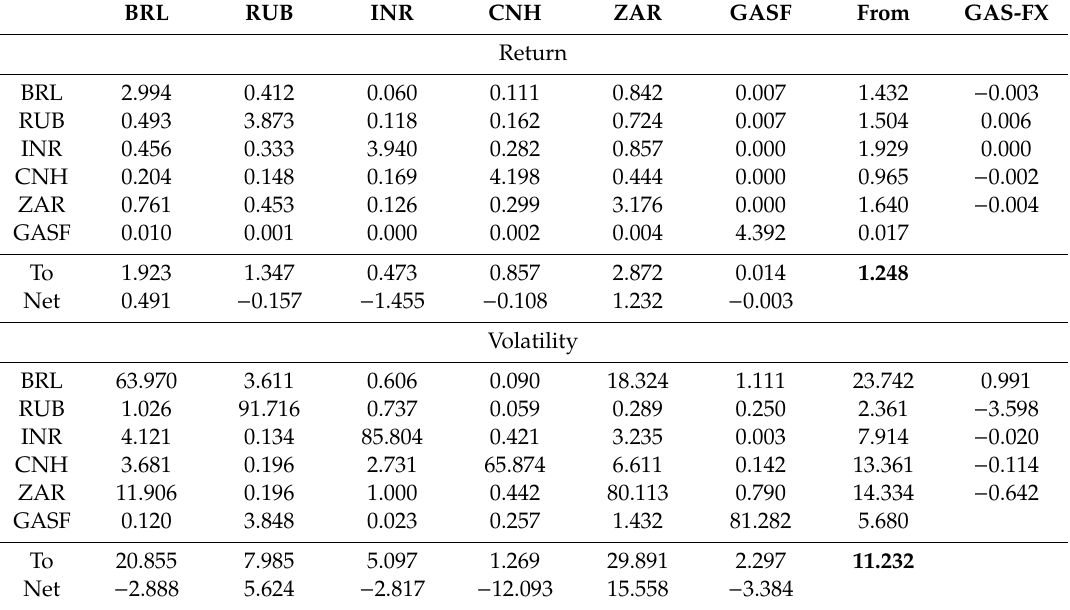
Table 9. Connectedness among the natural gas future price and exchange rates in the frequency domain (long